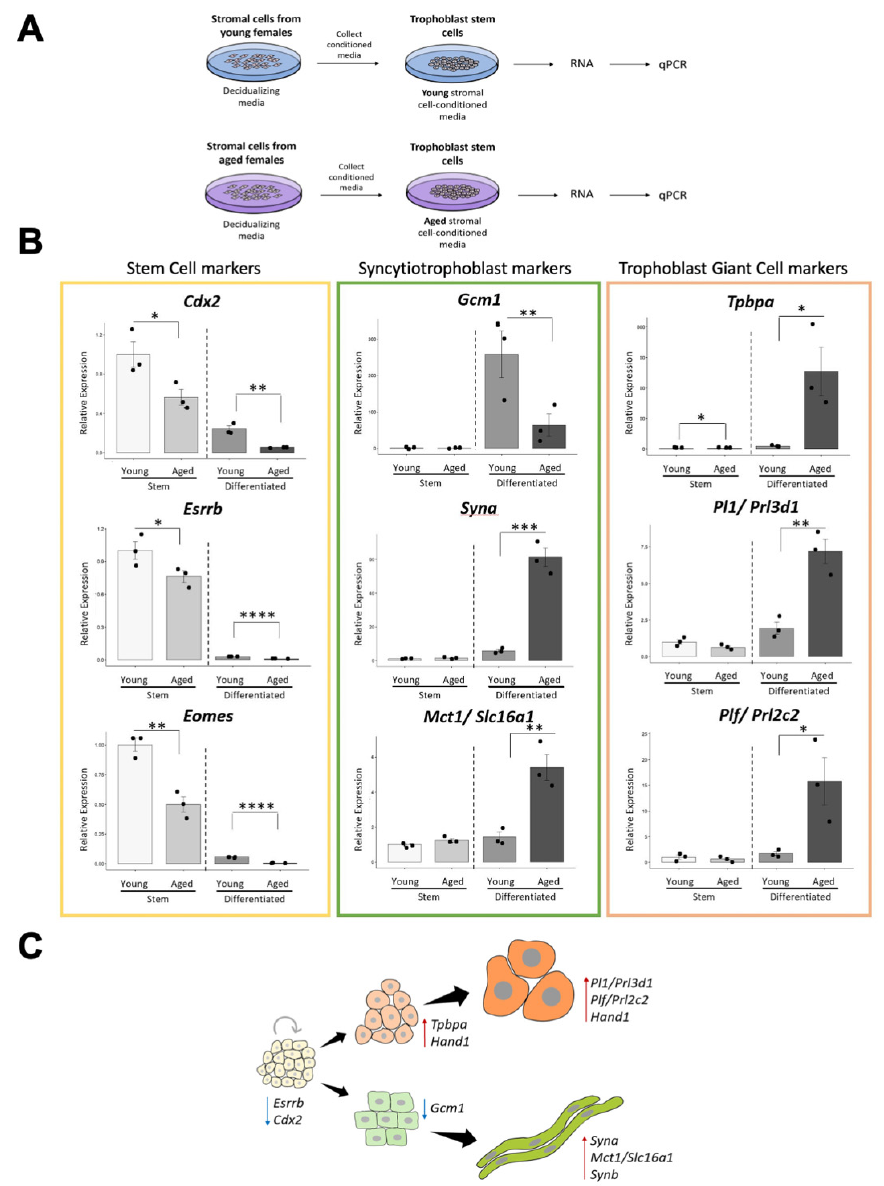
Figure 5. Aged decidual stromal-cell conditioned media accelerates differentiation of trophoblast stem cells. ( A ) Experimental set-up to explore the effect of uterine stromal cell conditioned medium obtained from cells of young vs. aged females on trophoblast stem cells. ( B ) RT-qPCR data of trophoblast cell-type specific marker genes upon exposure to young vs. aged decidual stromal-cell conditioned media. Cells were assessed in stem cell conditions and after three days of differentiation. Genes assessed are colour-coded for stem cell (yellow), syncytiotrophoblast (green) and trophoblast giant cell (orange) markers, respectively. Data are normalized to the stem cell conditions exposed to young conditioned media and plotted as mean +/ − SEM. Data are representative of three independent biological replicates. Statistical analysis was performed using a two-tailed Student’s t -test. * p < 0.05, ** p < 0.01, *** p < 0.001, ****p < 0.0001. ( C ) Schematic depicting the aged decidual stromal-cell effect on trophoblast stem cells. Trophoblast stem cells differentiate more rapidly into the giant cell and syncytiotrophoblast lineages and precociously exit the stem cell state. Red and blue arrows indicate up- and down-regulation of genes, respectively.